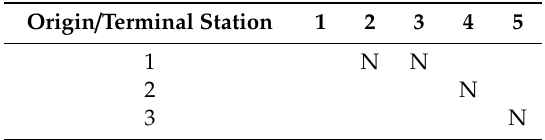
Figure 2. An illustration of operation zones and stop plans for additional trains. Table 1. Passenger demand for each origin-destination (OD) pair.